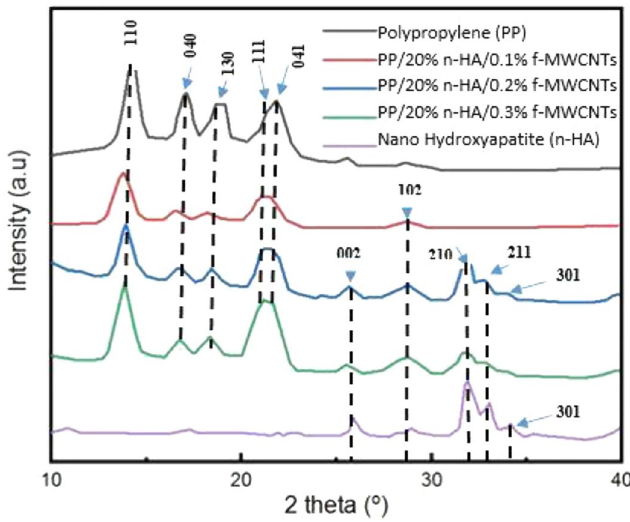
Figure 1. X-ray Pattern for Polypropylene (PP), PP/20% n-HA/0.1% f-MWCNTs, PP/20% n-HA/0.2% f-MWNTs, PP/20% n-HA/0.3% f-MWCNTs and Nano Hydroxyapatite